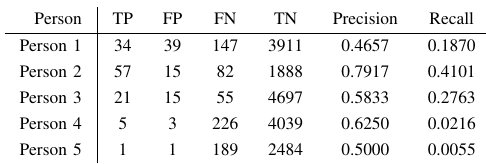
TABLE IV: Detailed evaluation of the eating